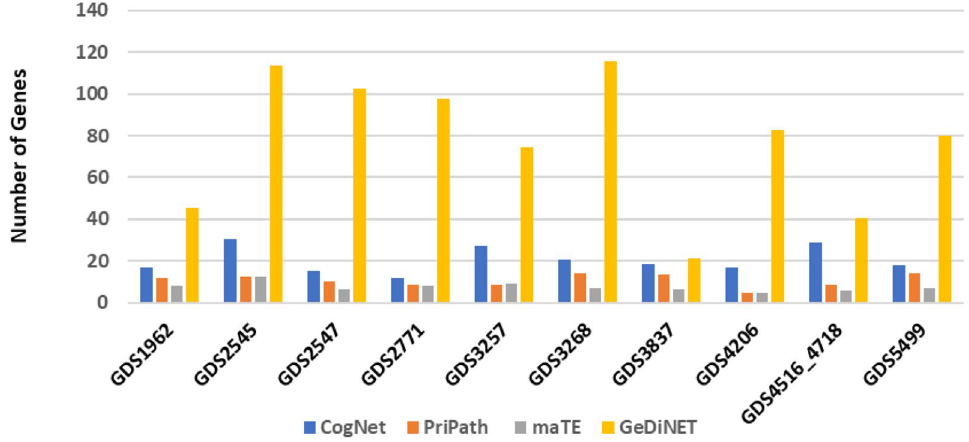
Figure 8. The mean number of genes of GediNET, CogNet, maTE and PriPath tools for ten different datasets for the top two groups.